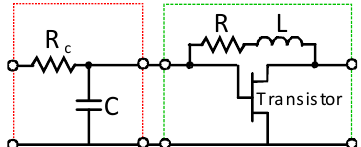
Figure 13: RC- and NGD active-circuit cascaded [51, 58].